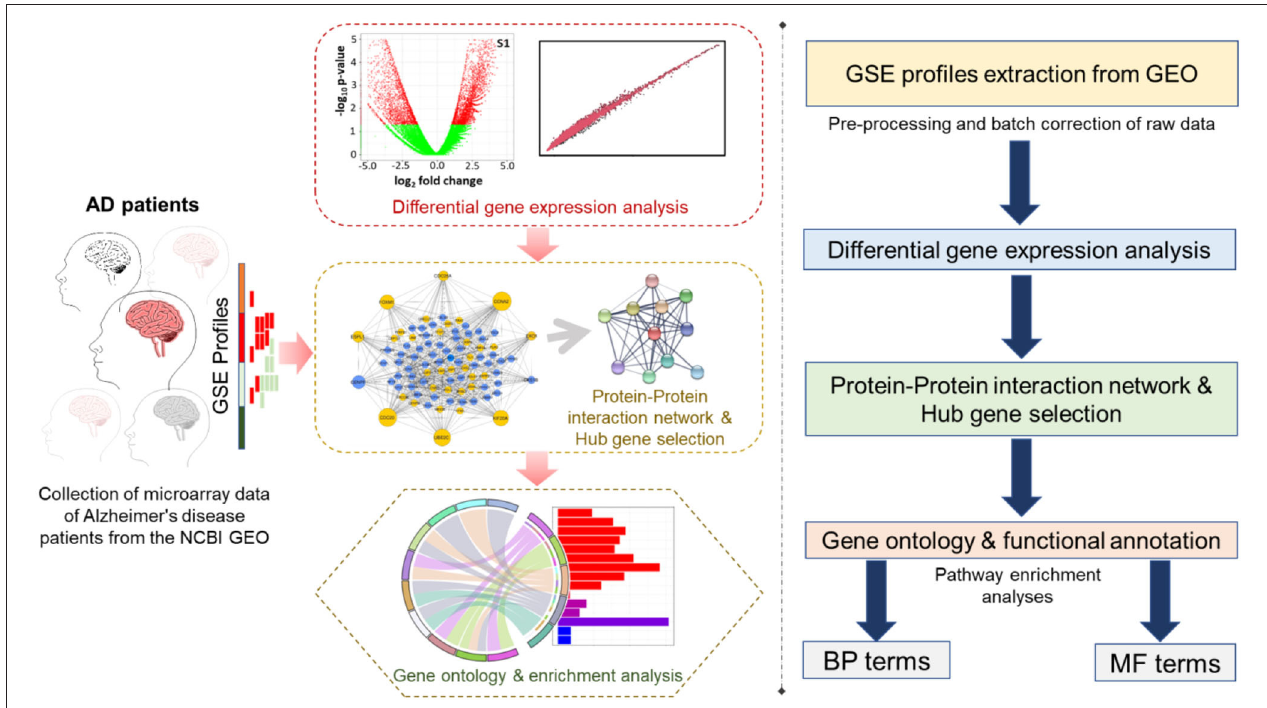
FIGURE 1 | The work pipeline available in this study is represented in graphical (left panel) and arrow box representation (right panel)